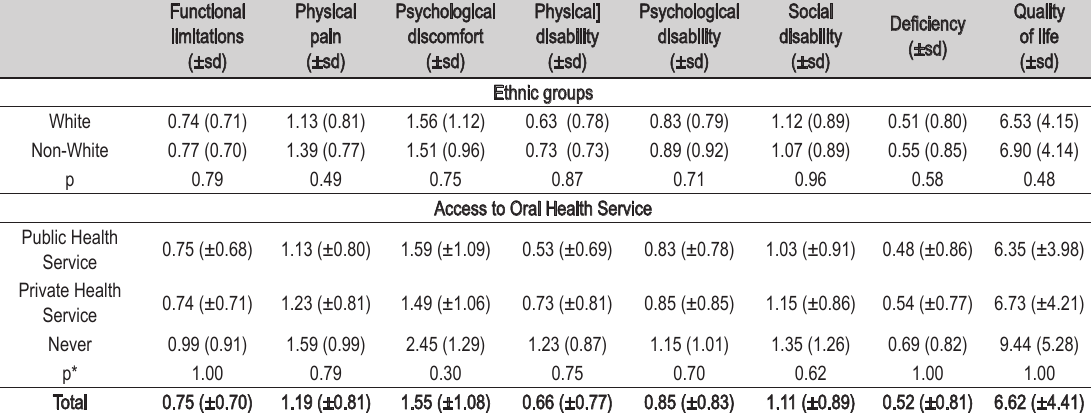
Table 3 - Oral health-related quality of life and domains according to gender and ethnic groups, Agudos, SP, 2012.